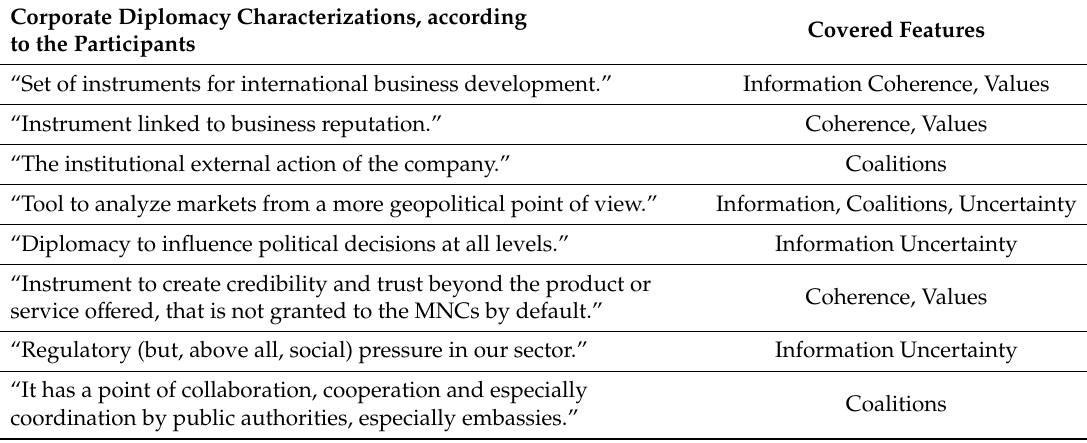
Table 5. Non-market attributes. Focus Group